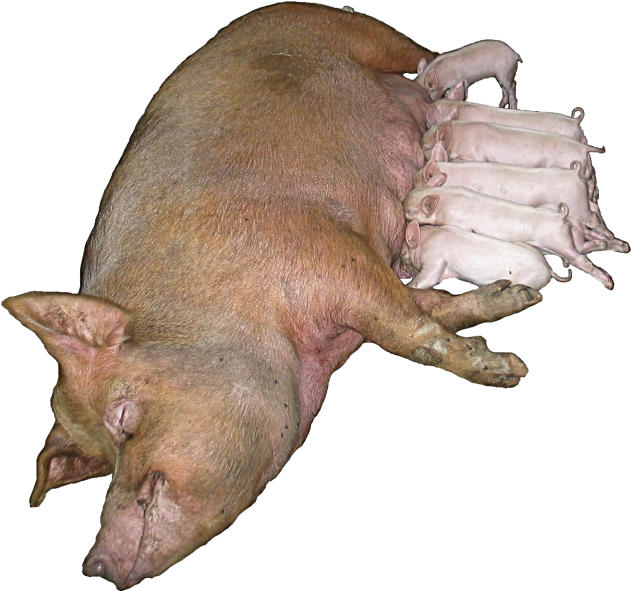
Natural selection favors the sole expression of maternal gene copies, because it allows for the genetic coadaptation of maternal offspring traits and leads to higher offspring fitness.